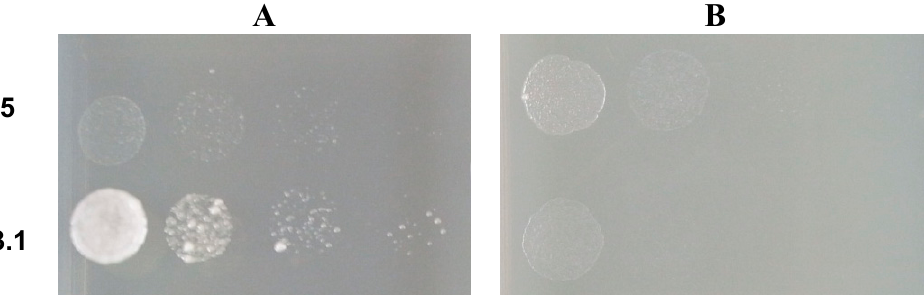
Figure 4. Functional complementation of AhYSL3.1 in yeast. The yeast strain M10 was transformed with the AhYSL3.1-pDR195 construct or the empty pDR195 vector, which was used as a negative control. Serial dilutions of the transformed yeast cells of OD 600 1 to 0.001 were plated onto Synthetic Defined (SD) medium containing 9 μ M Cu–NA ( A ) or 10 μ M CuSO 4 ( B ).